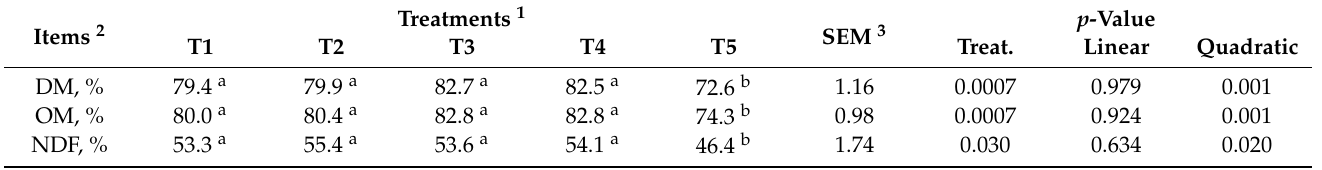
Table 5. Apparent digestibility for dietary treatments with different levels of sprouted barley in vitro.